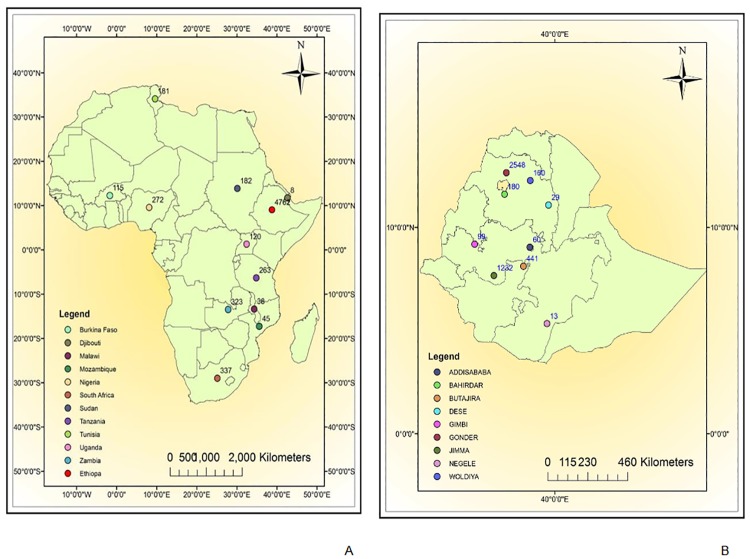
Geographic distribution and number of TBLN cases in Africa and Ethiopia, Africa, 1970–2015.